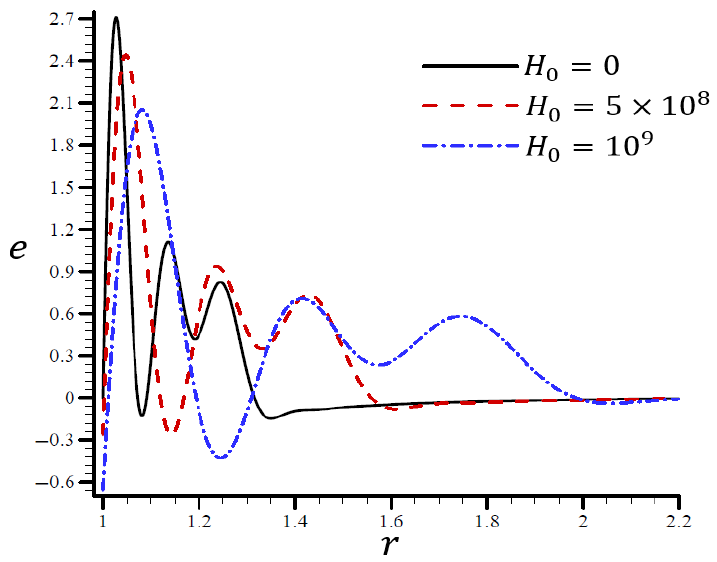
Figure 13. The influence of H 0 on volumetric strain e through the radial direction of the spherical hole using the RTPL model.